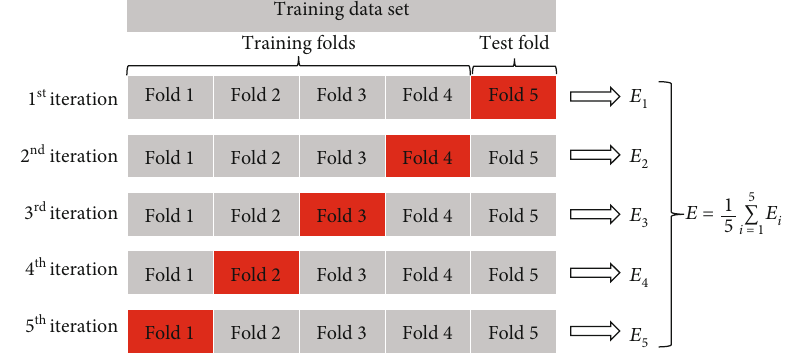
Figure 6: Fivefold